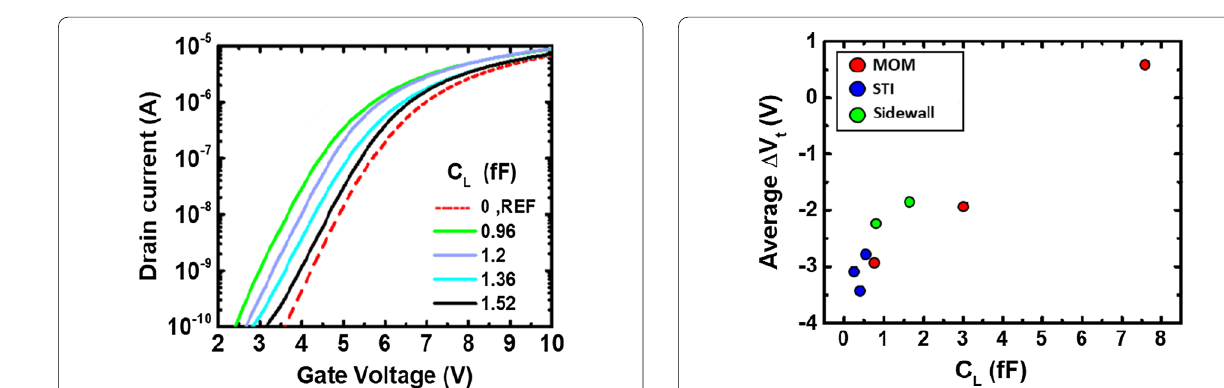
Fig. 8 I–V curve of different sizes of STI capacitor with AR the external capacitance is larger, the I–V curve is closer to that of the reference cells